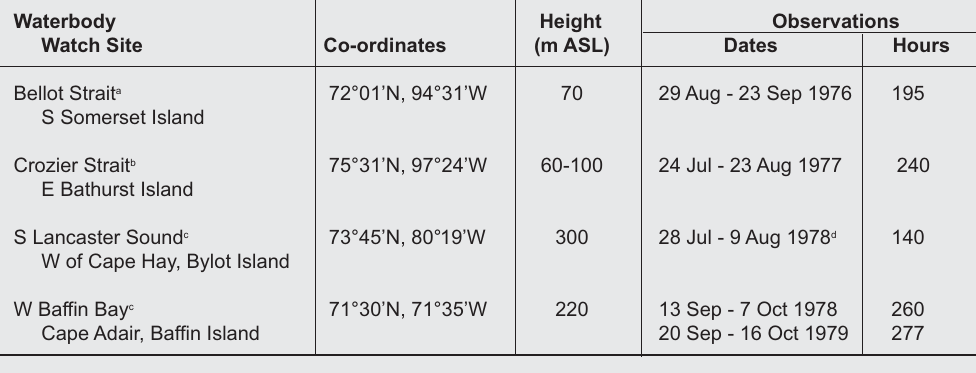
Table 1. Shore-based watches for migrating marine mammals. For locations, see Fig. 2.